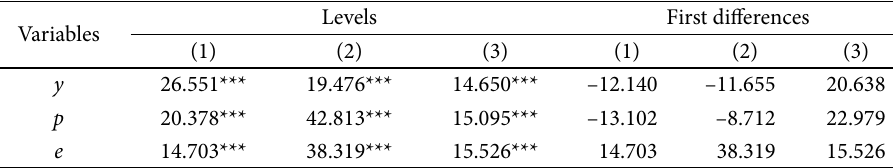
Table 2. Hadri unit root